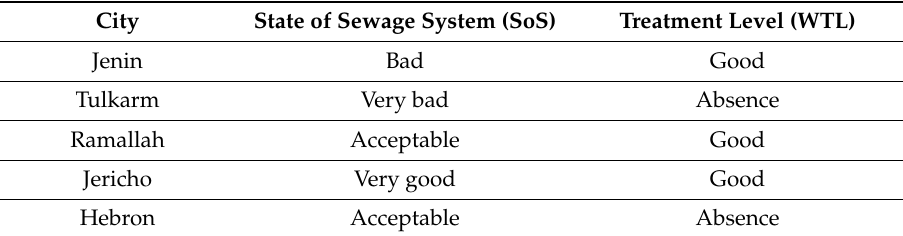
Table 10. State of the sewage system (SoS) and wastewater treatment level (WTL). City State of Sewage System (SoS) Treatment Level (WTL) Jenin Bad Good Tulkarm Very bad Absence Ramallah Acceptable Good Jericho Very good Good Hebron Acceptable Absence